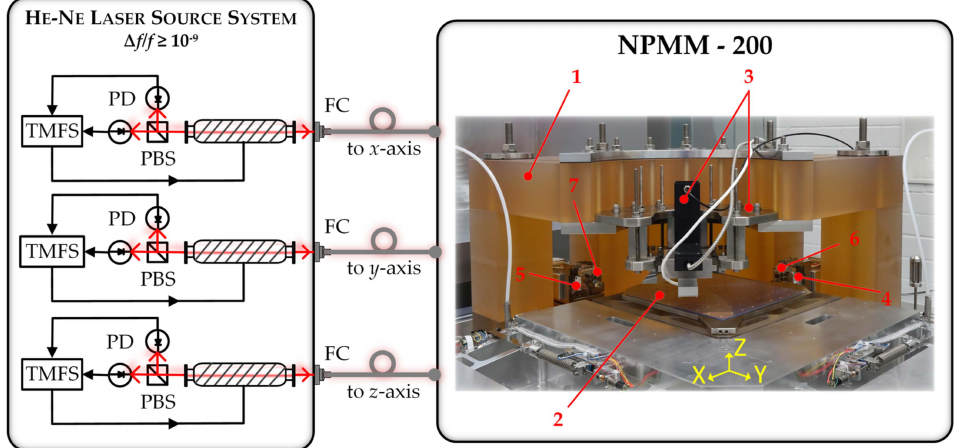
Figure 1. Setup of the NPMM-200 and its He-Ne laser source for three interferometer axes. The abbreviations in the left picture denote: TMFS—two-mode frequency stabilization, PD—photodiode, PBS—polarizing beam splitter, FC—fiber coupling. The numbers in the right picture correspond to: 1—metrology frame, 2—Positioning stage with corner mirror plate, 3—Sensor mount with nano probe system, 4, 5—Interferometer x , y -axis, 6, 7—Autocollimators (angle sensors). The